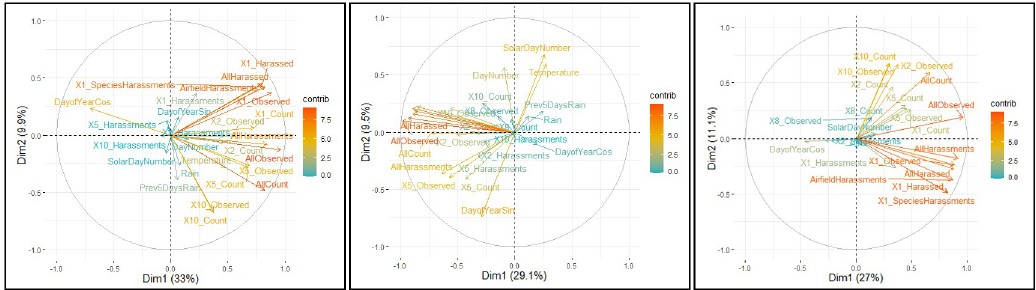
Fig 11. Hazard species—Principal Component Analysis, PC1 and PC2 for Cattle Egret, Straw-necked Ibis, and Nankeen Kestrel. For any variable, its contribution to overall variance is given by the distance from the origin (vector length) and is colour- coded (blue indicates a lower contribution, and red the highest). (a) Plot of contribution of variables to PC1 and PC2 for Cattle Egret. (b) Plot of contribution of variables to PC1 and PC2 for Straw-necked Ibis. (c) Plot of contribution of variables to PC1 and PC2 for Nankeen